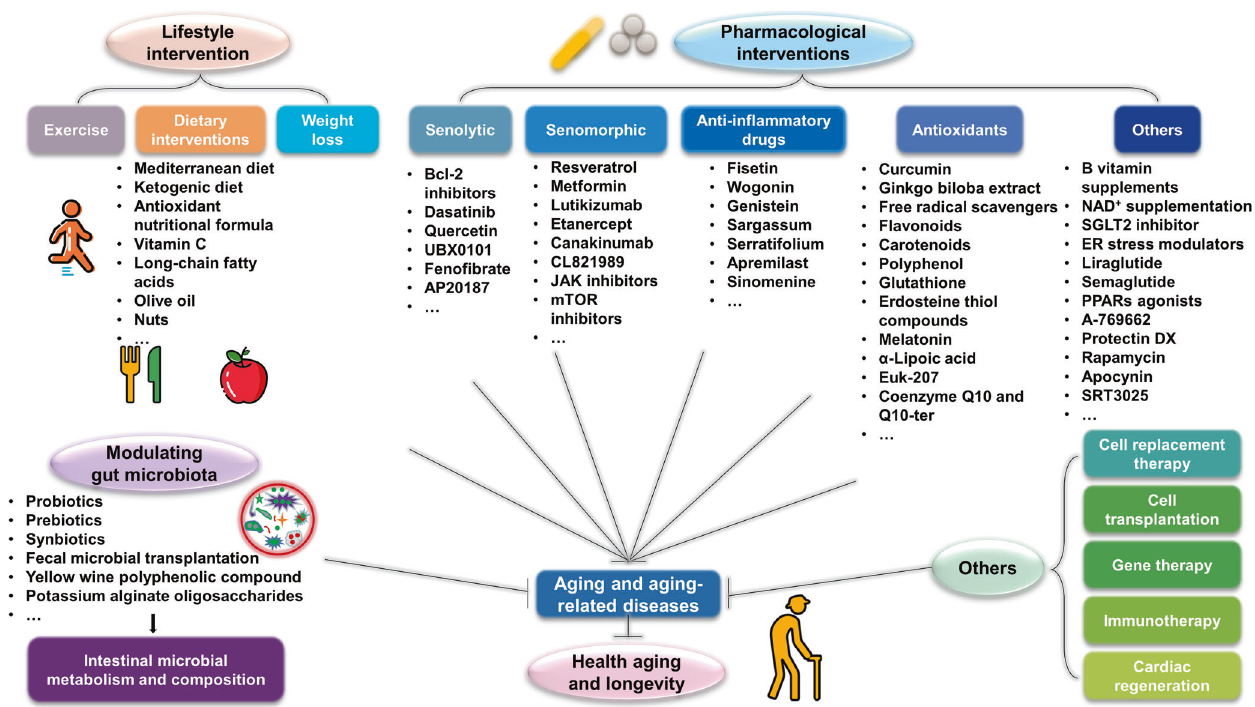
Fig. 8 Possible interventions and treatments against aging-related diseases. Proof-of-principle therapeutic strategies used in cell experiments, animal experiments, and clinical trials are shown together. Daily lifestyle changes, such as exercise, dietary interventions, and weight loss, can inhibit aging and reduce the occurrence and development of aging-related diseases, subsequently promoting healthy aging and longevity. Drug therapy is the main strategy targeting aging. Antiaging drugs exert their effects by reducing the number of senescent cells, alleviating the SASP, and exerting anti-in fl ammatory and antioxidant effects while affecting multiple signaling pathways. Altering the metabolism or composition of the gut microbiota with drugs or through microbiota transplantation can also inhibit aging and aging-related diseases. Moreover, cell replacement therapy, cell transplantation, gene therapy and immunotherapy can be used to promote healthy aging and longevity and to treat aging-related diseases. mTOR mammalian target of rapamycin, NAD + nicotinamide adenine dinucleotide,